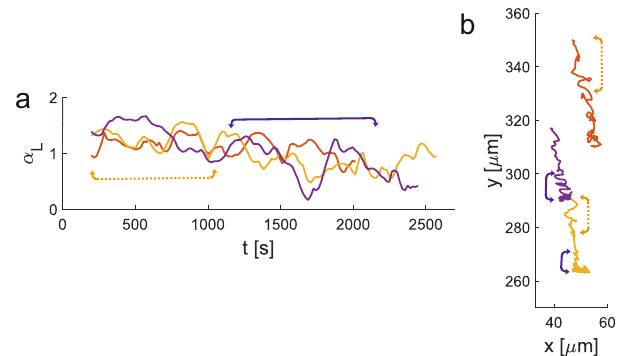
Fig. 6 Coherent oscillations of local anomalous exponents reveal synchronised movement of non-contacting hemocytes. a Oscillating local anomalous exponents of sample trajectories of hemocytes in LanB1 . b Corresponding trajectories of hemocytes which appear to move in a synchronised manner. Arrows highlight coherent portions in trajectories and corresponding local anomalous exponents. Correlation coef fi cients of pairs of local anomalous exponents in ( a ) were 0.87 and 0.76 in the fi rst and the second coherent portions highlighted by arrows. The correlation coef fi cients between pairs of trajectories in ( b ) were close to 1 (see also Supplementary Fig.